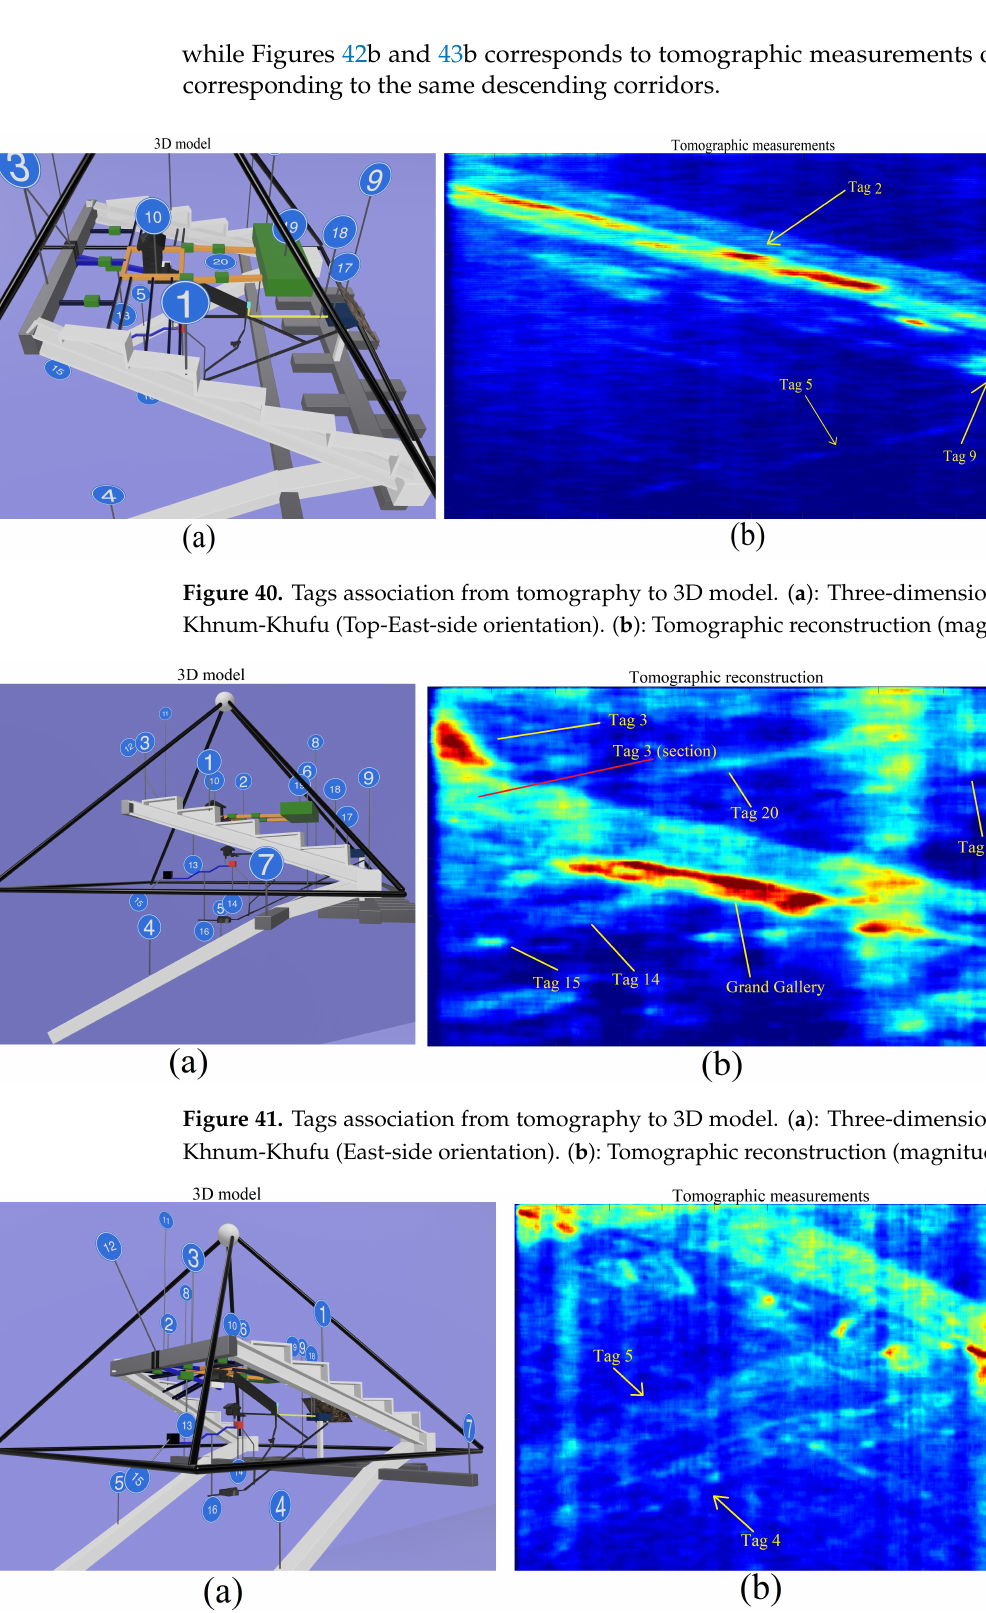
Figure 42. Tags association from tomography to 3D model. ( a ): Three-dimensional (3D) model of Khnum-Khufu (South-East-side orientation). ( b ): Tomographic reconstruction